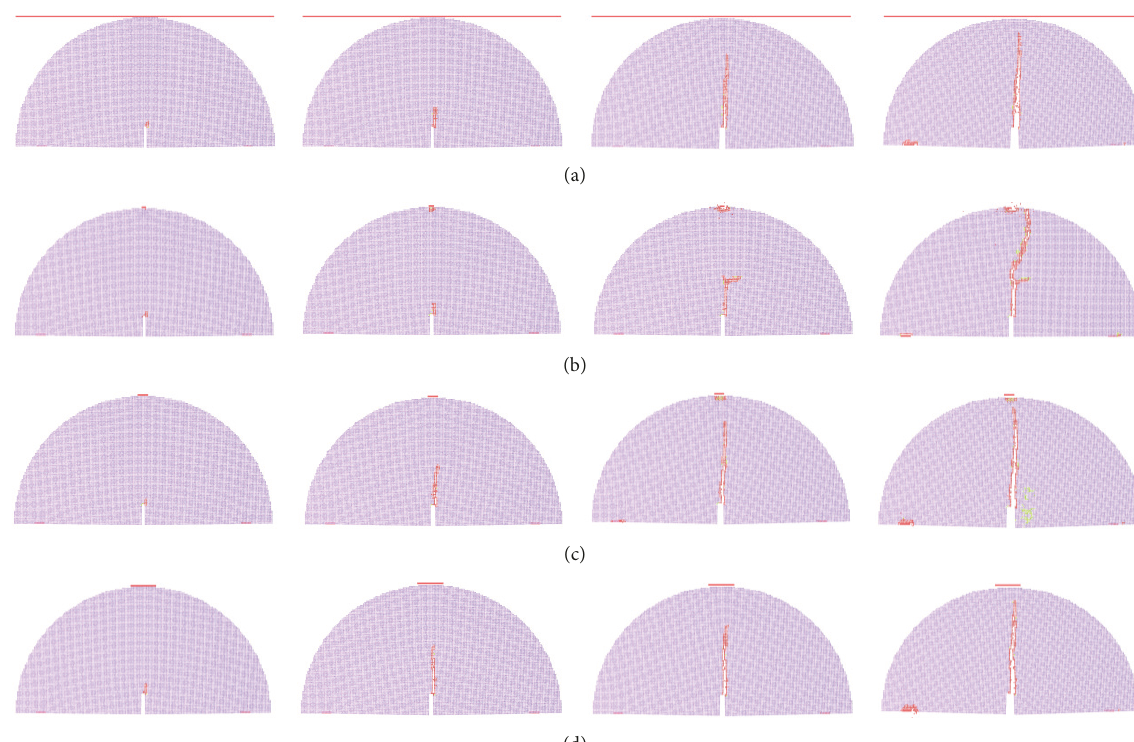
Figure 17: DLSM calculated